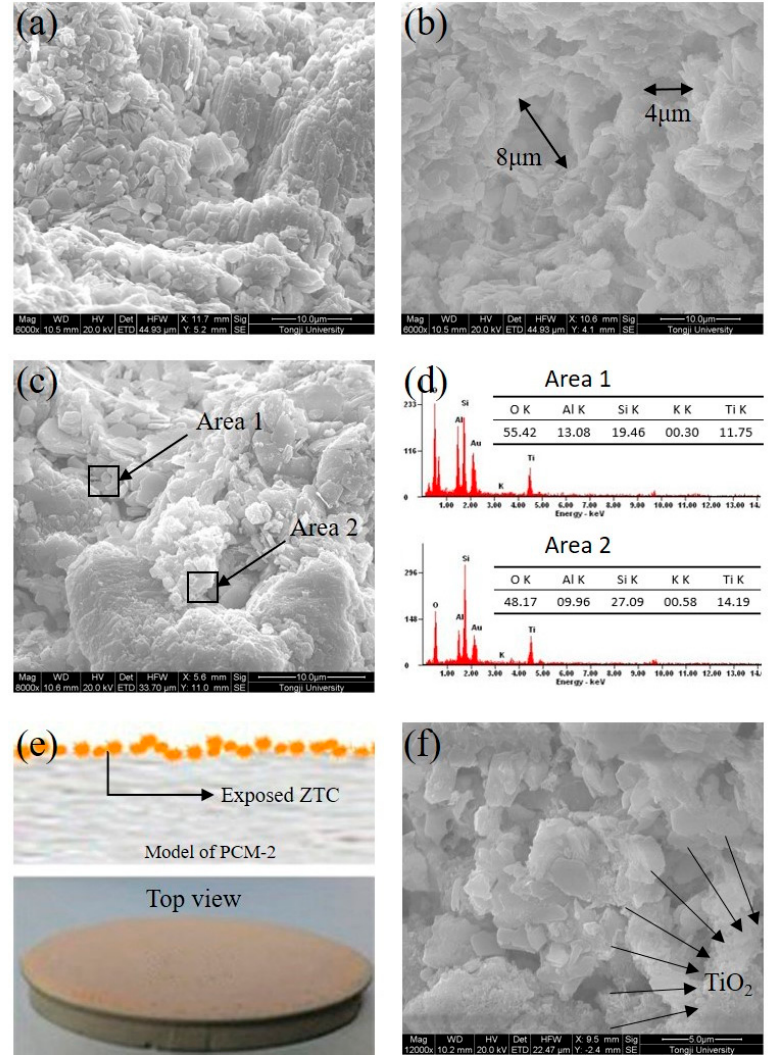
Figure 3. Surface morphology and EDS analysis: ( a ) SEM image of NZ; ( b ) SEM image of MZ; ( c , d ) SEM image of ZTC-2 with EDS; ( e ) photograph of the surface layer of PCM-2; ( f ) SEM image of exposed ZTC-2.